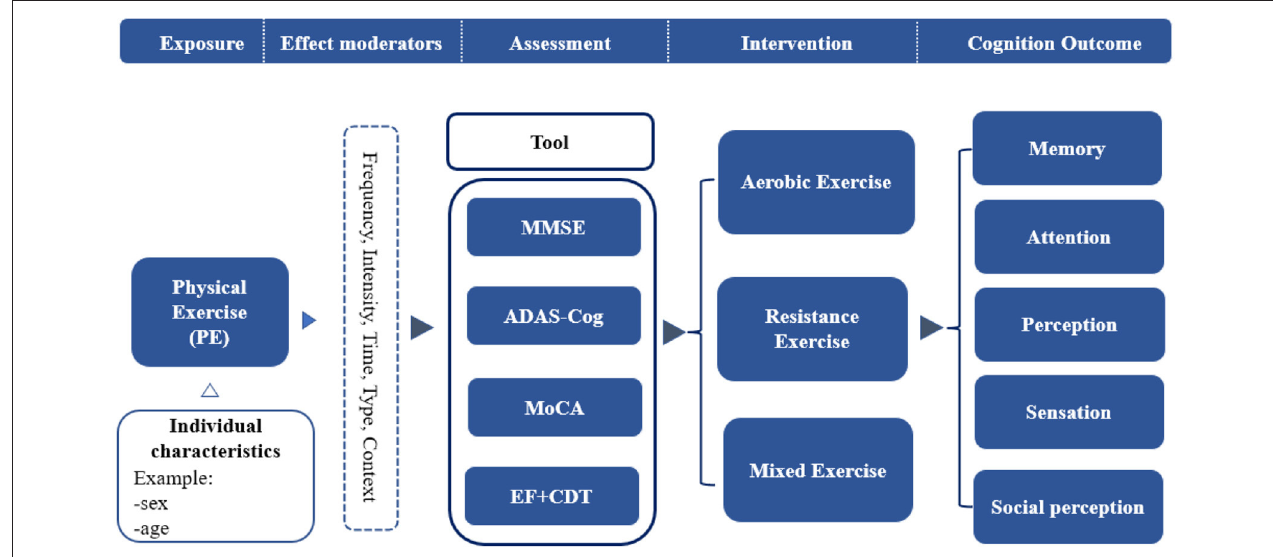
FIGURE 1 | A conceptual model of physical exercise intervention for cognitive